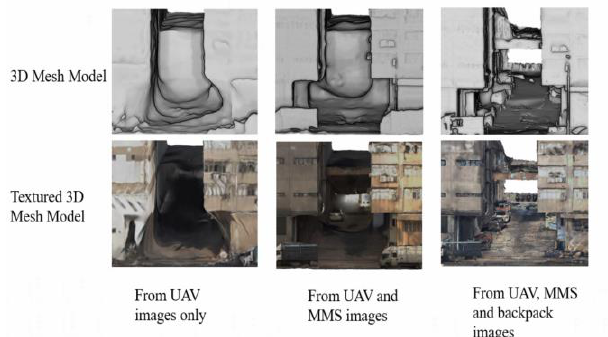
Figure 12. Comparison of the 3D models in a narrow alley where MMS images were obtained in the alley.